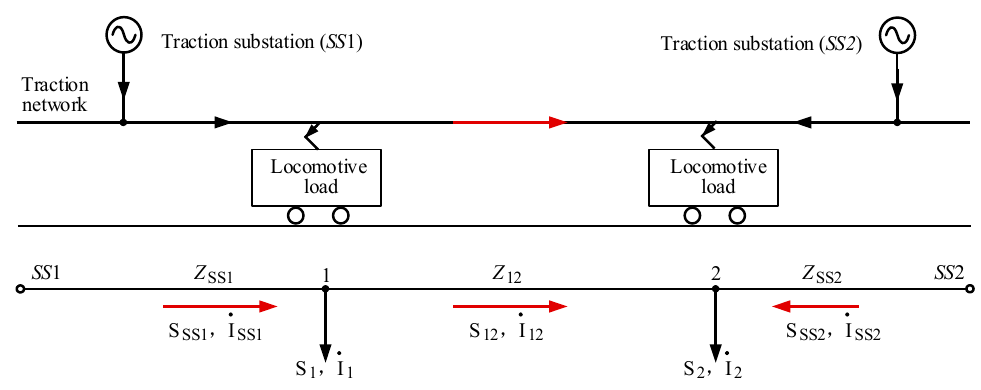
Figure 10. The model of ACTPSS with two traction substation.